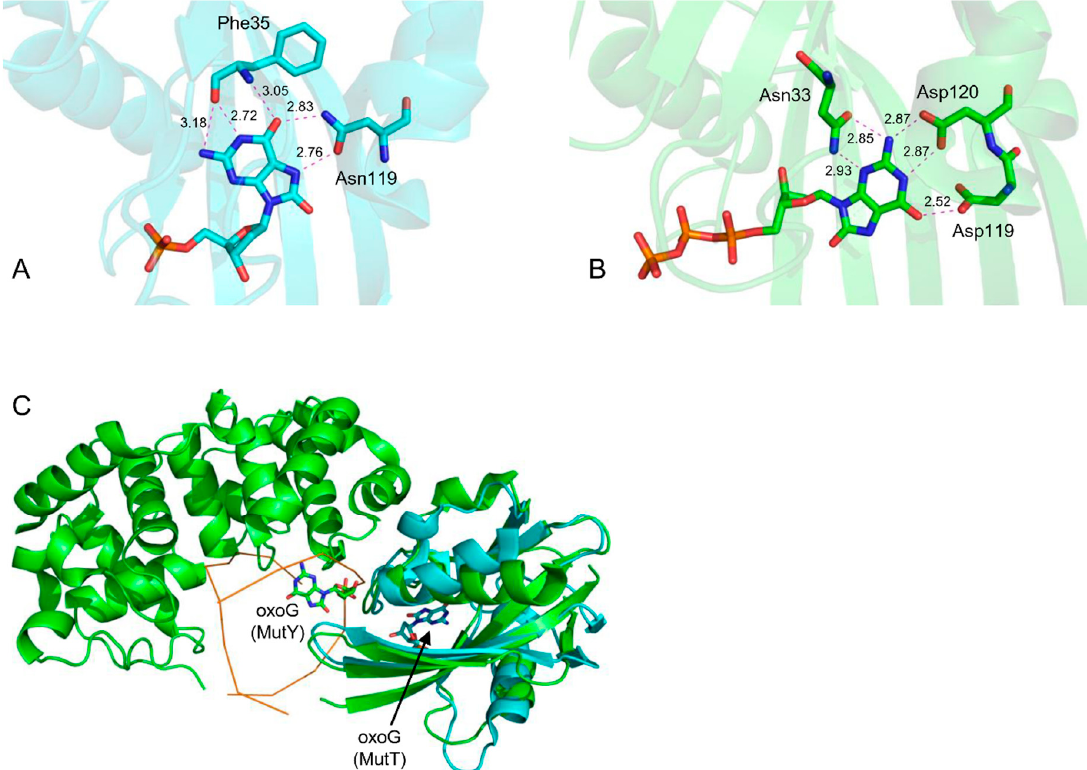
Figure 5. Recognition of oxoG by NUDIX domain enzymes. ( A ) E. coli MutT recognizing oxodGMP